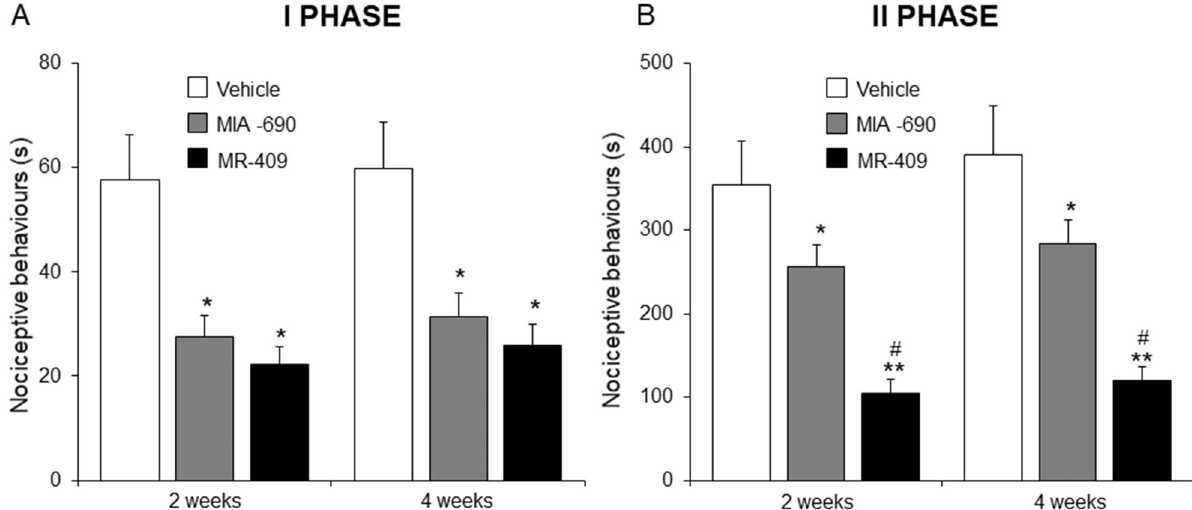
Figure 5. Effect of MIA-690 (5 µg) and MR-409 (5 µg) s.c. administration on the acute nociceptive response in formalin test (n = 6 for each group of treatment). The nociceptive behaviour time (seconds) of licking, shaking and biting was measured during the period of 0–5 min (first phase) and 20–60 min (second phase). Data are expressed as means ± S.E.M. and analyzed by analysis of variance (ANOVA) followed by Bonferroni post-hoc test * p < 0.05, ** p < 0.01 versus vehicle; # p < 0.05 versus